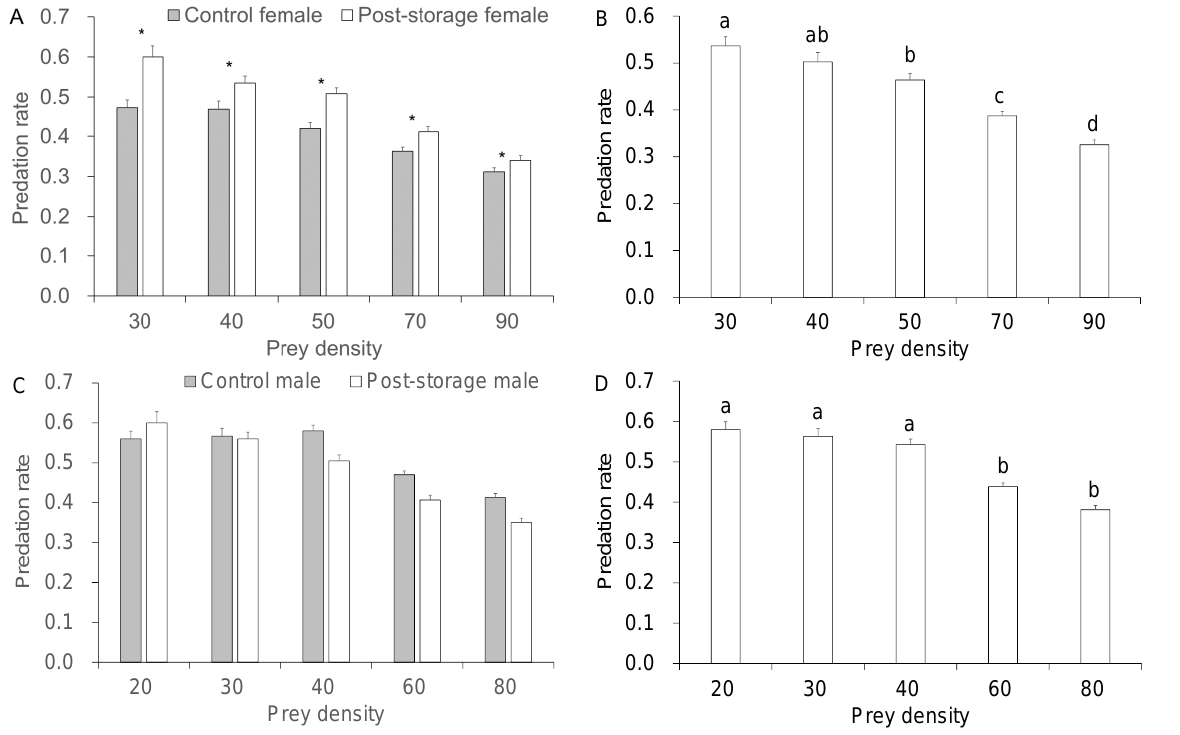
Figure 1. Predation of Nilaparvata lugens eggs by post-storage and control Cyrtorhinus lividipennis